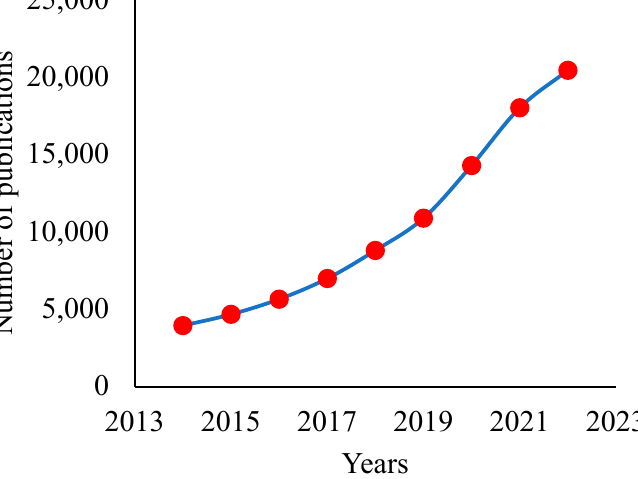
Figure 1. Publication trend of articles on fabricated membranes for organic solvent separation.